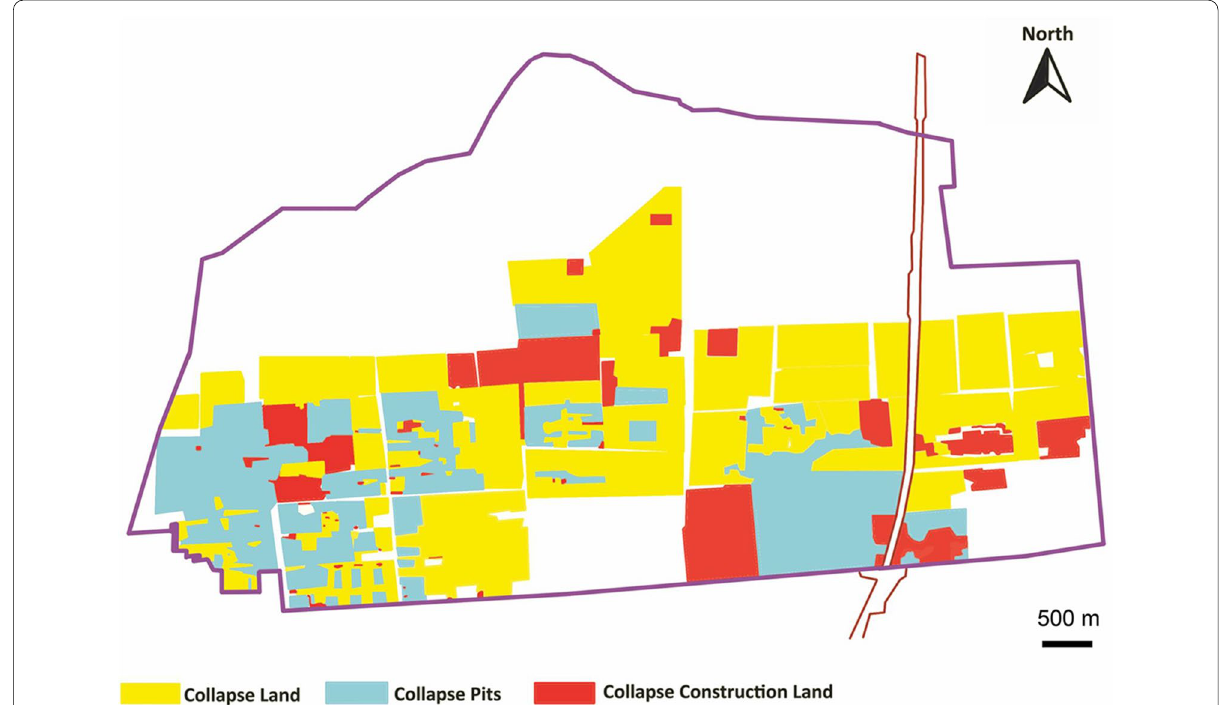
Fig. 4 Map showing the distributions of subsided pits (greyish-blue), subsided agriculture/unused land (yellow), and subsided construction land (red) in the Dawu mining district, Jiangsu province